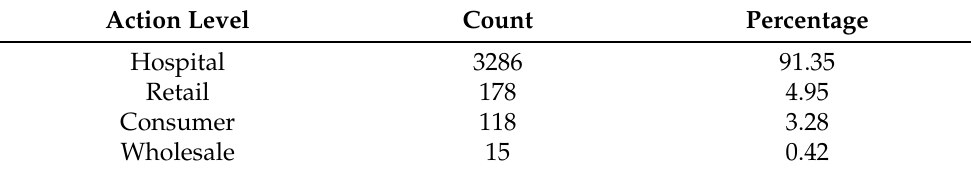
Table 2. The level at which recalls are made for all medical devices in System for Australian Recall Action (SARA).